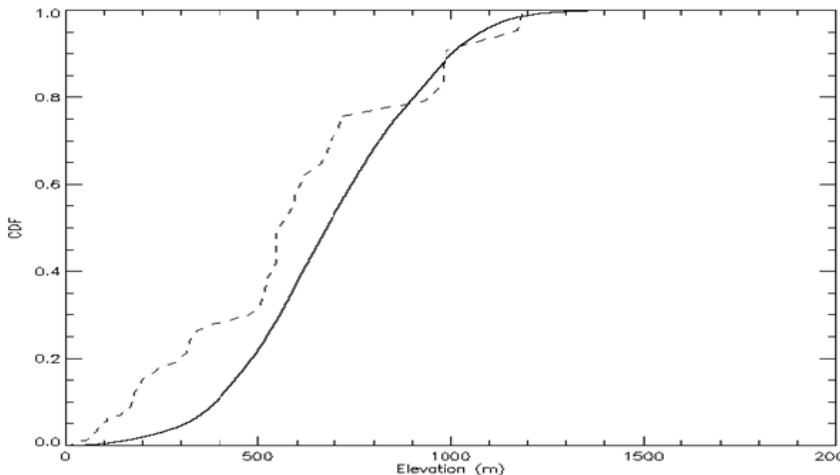
Figure 1. Cumulative probability function: Digital Elevation Model and Mesonet sites.